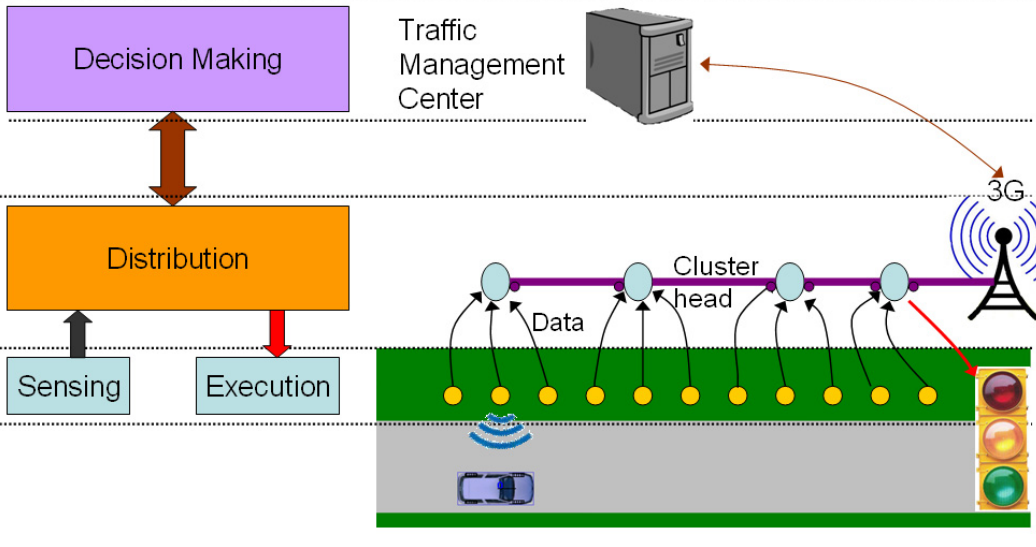
Figure 2. Reference architecture for WSN-based ITS